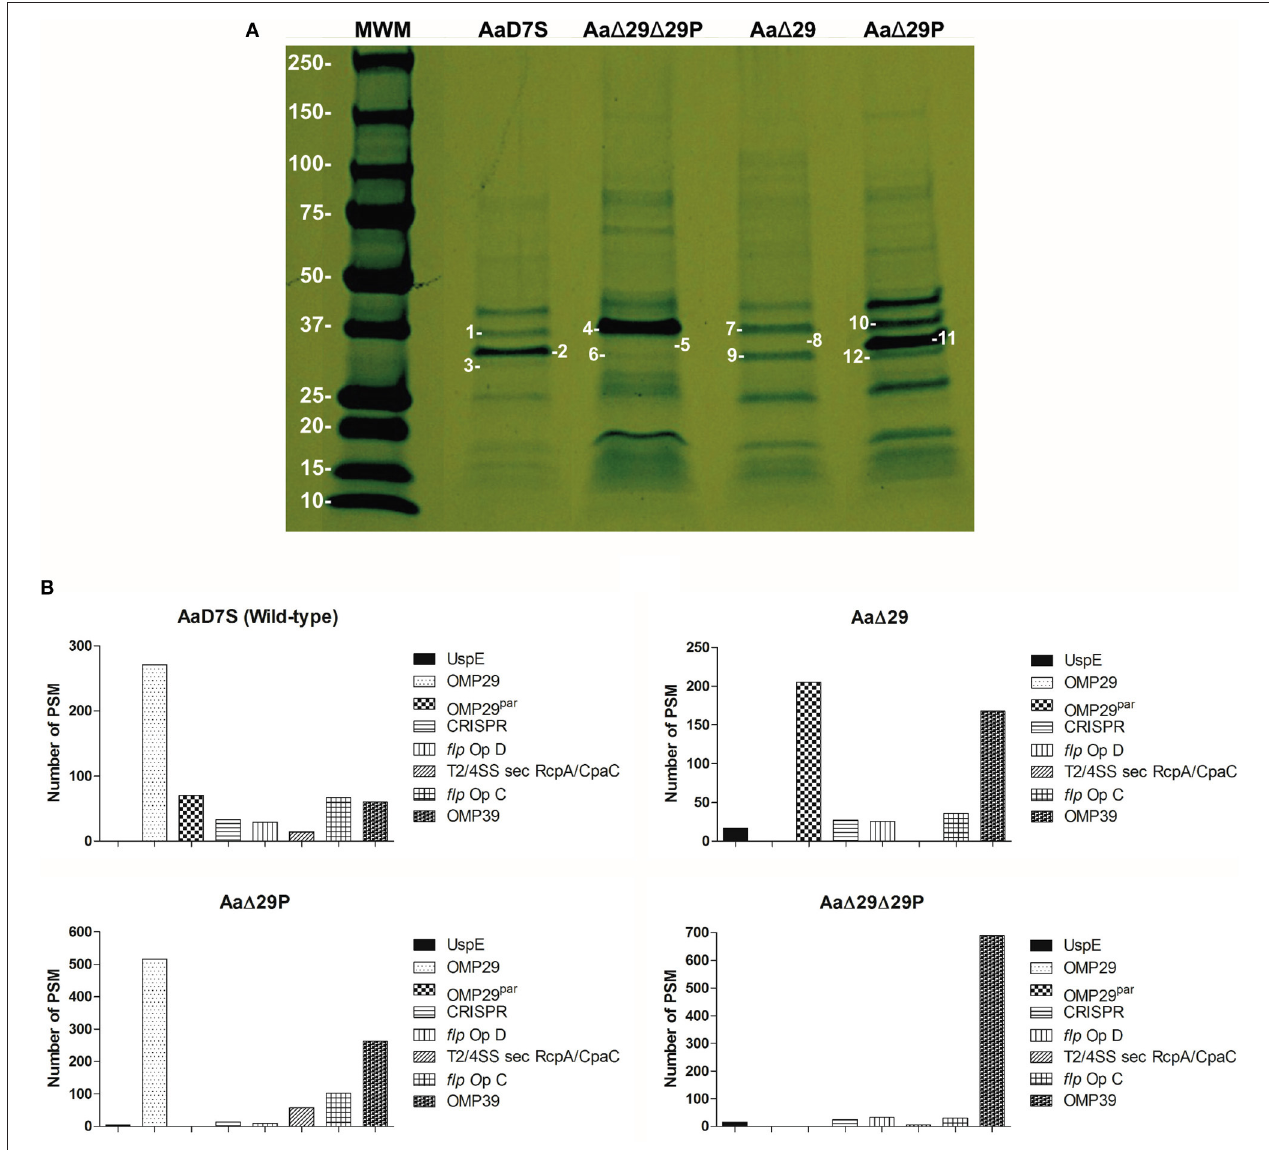
FIGURE 1 | Outer membrane extracts profile of Aa D7S-1 strains. (A) Outer membrane protein profiles of Aa grown until mid-log phase were determined by SDS-PAGE analysis: MWM: Molecular Weight Marker—Precision Plus Protein Standard, Bio-Rad, in kDa. Gel slices numbered 1-12 showed the following OMPs: AaD7S, 1-OMP39, 2-OMP29; 3-OMP29 par ; Aa 1 29 1 29P, 4-OMP39, 5-OMP29 absent; 6-OMP29 par absent; Aa 1 29, 7-OMP39, 8-OMP29 absent; 9-OMP29 par ; Aa 1 29P, 10-OMP39, 11-OMP29; 12-OMP29 par absent). Photograph of a representative gel of at least two independent assays. (B) Proteomic analysis of detected peptides or peptide spectrum matches (PSM) for the 8 major proteins: (Universal stress protein UspE, OMP29, OMP29 par , CRISP-associated protein (CRISP), flp operon protein D ( flp Op D), type II/IV secretion system secretin RcpA/CpaC (T2/4SS sec RcpA/CpaC), and flp operon protein (flp Op C) and OMP39) after combining gel #1-3, gel #4-6, gel #7-9, and gel #10-12, to determine whether some proteins were differentially expressed in AaD7S and its mutants Aa 1 29 1 29P, Aa 1 29, and Aa 1 29P, respectively. AaD7S, Aa D7S-1 wildtype strain; Aa 1 29, Aa D7S-1 omp29 mutant strain; Aa 1 29P, Aa D7S-1 omp29 par mutant strain; Aa 1 29 1 29P, Aa D7S-1 omp29 and omp29 par mutant